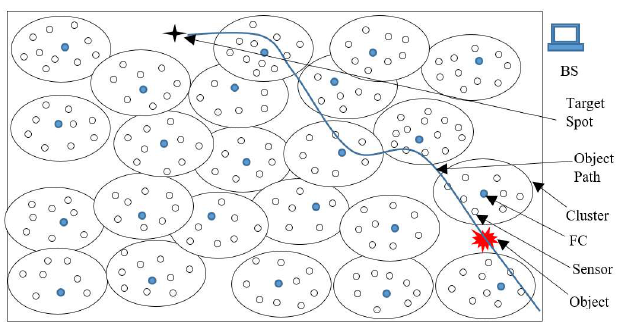
Figure 1. Network Figure 1. Network model.